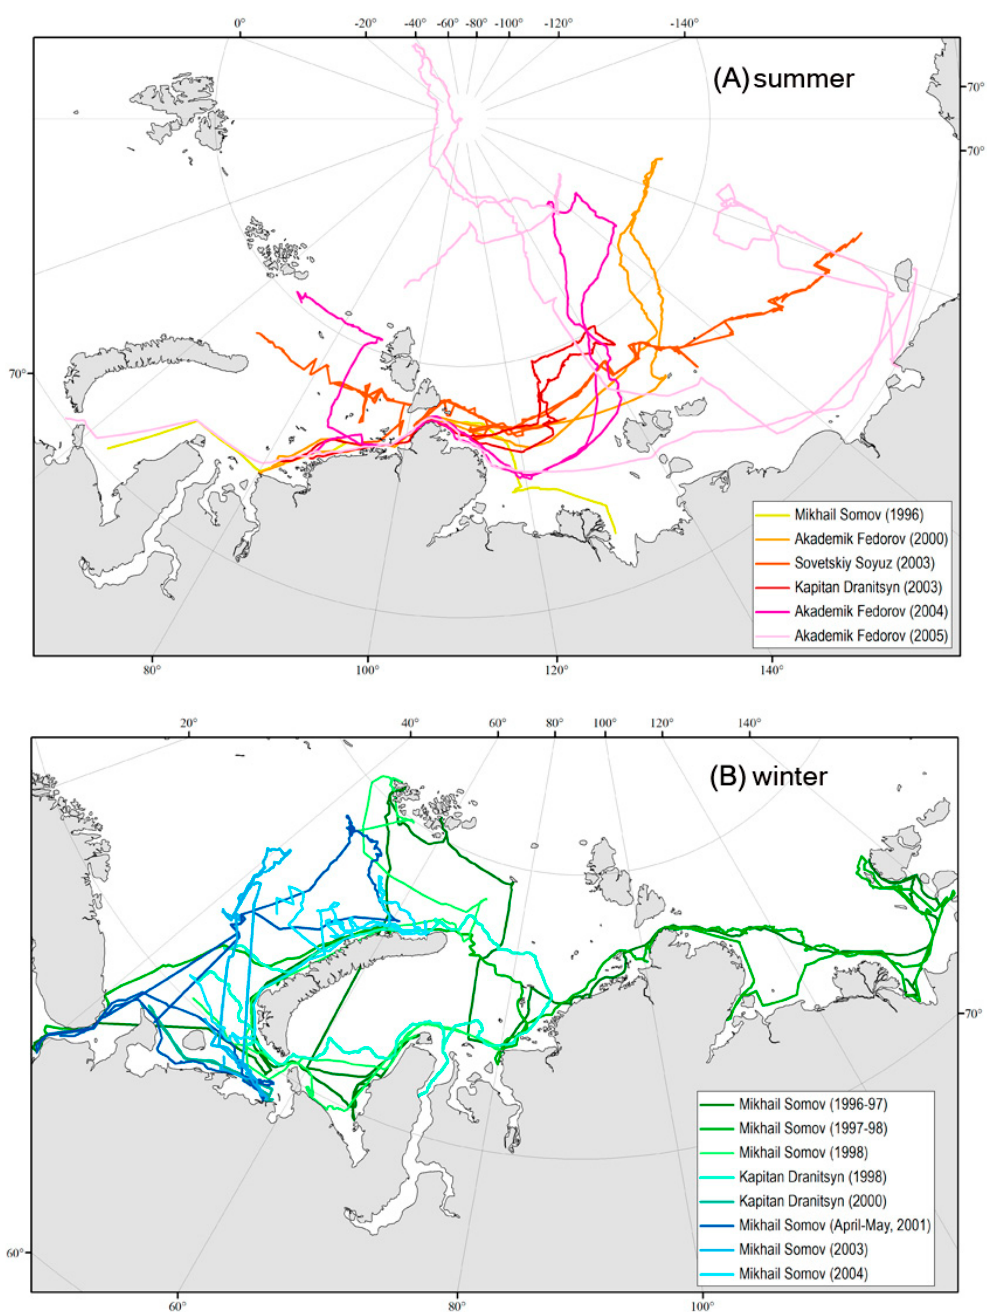
Figure 2. Cruise tracks of the research vessels and icebreakers that hosted the dedicated summer ( A ) and winter ( B ) ice